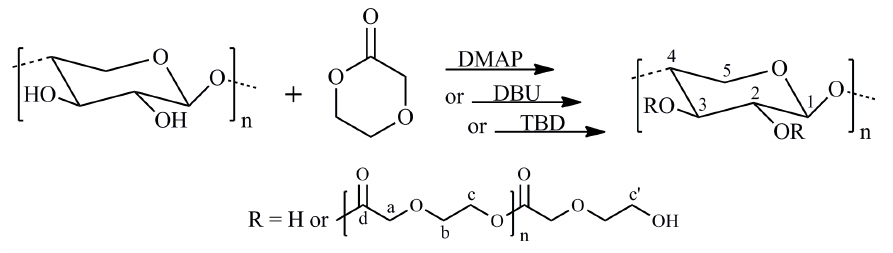
Scheme 1. Ring-opening graft polymerization of PDO onto xylan with different organic catalysts in [Bmim]Cl. [Bmim]Cl.